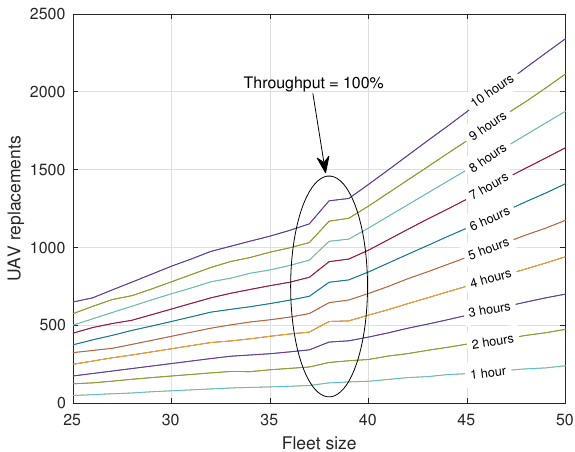
Figure 9. Number of UAV replacements using BETA in scenario